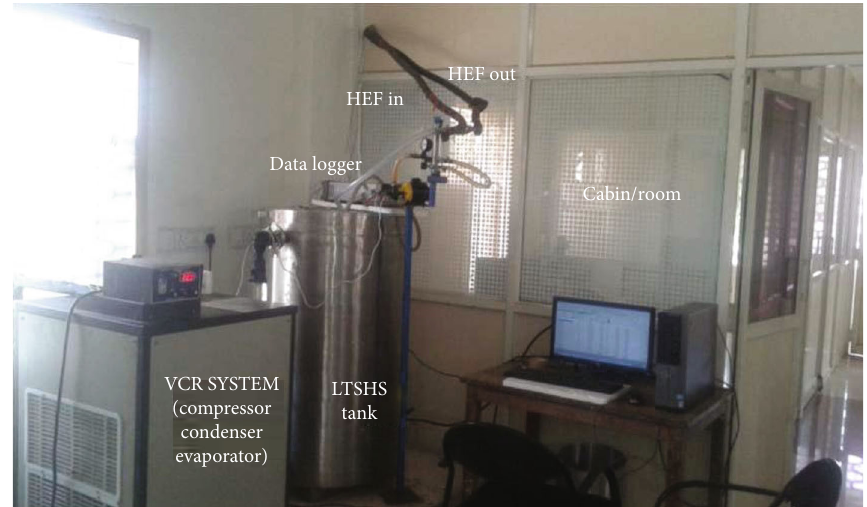
Figure 2: Photographic view of the experimental